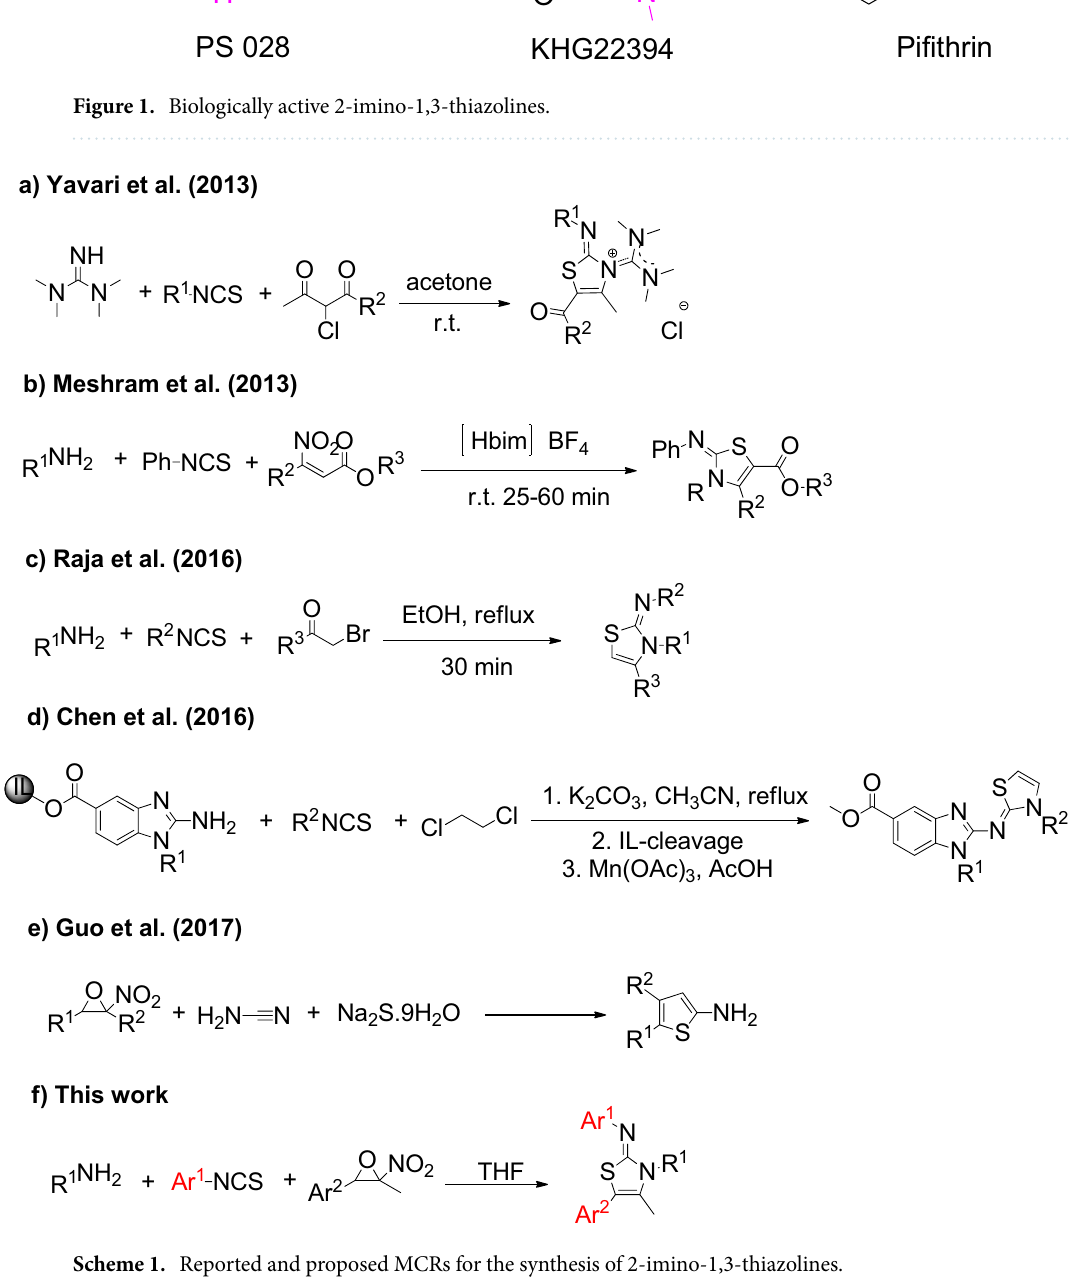
Scheme 1. Reported and proposed MCRs for the synthesis of